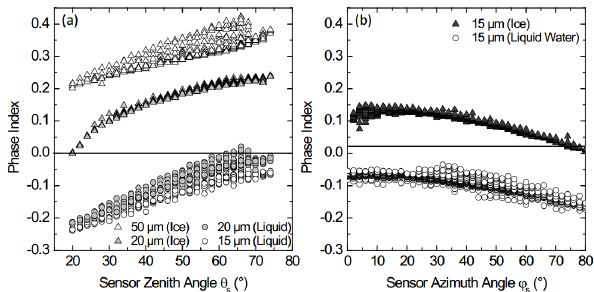
Fig. 5. (a) Phase index derived from water and ice clouds with uni- form r eff and varied sensor zenith angles. (b) Same as (a) but for varied sensor azimuth angle ( r eff